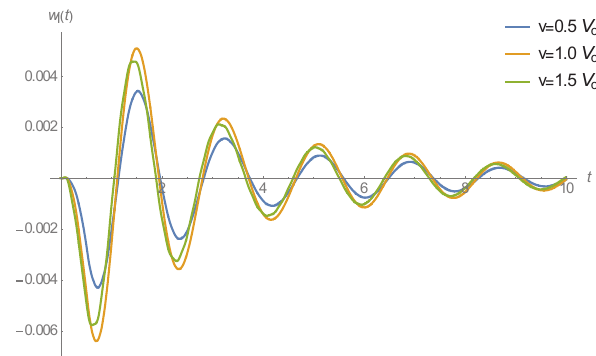
Figure 6: Deflection of the structure without an absorber in the middle of the beam for three velocities.